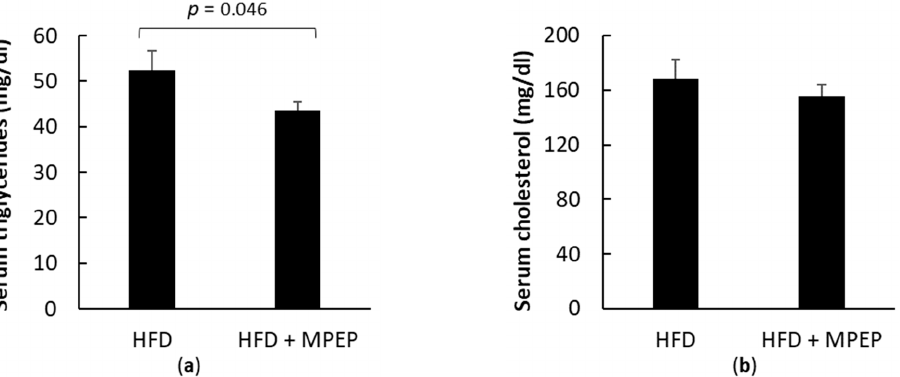
Figure 3. Plasma triglycerides and cholesterol in obese mice. ( a ) Triglycerides in plasma from obese mice after 7 weeks of HFD administration treated with MPEP 20 mg/Kg or vehicle; ( b ) Cholesterol in plasma from obese mice after 7 weeks of HFD administration treated with MPEP 20 mg/Kg or vehicle. HFD: high-fat diet + vehicle group; HFD + MPEP: high-fat diet + 20 mg/Kg MPEP group. Results are mean ± SE of 6 individual determinations.